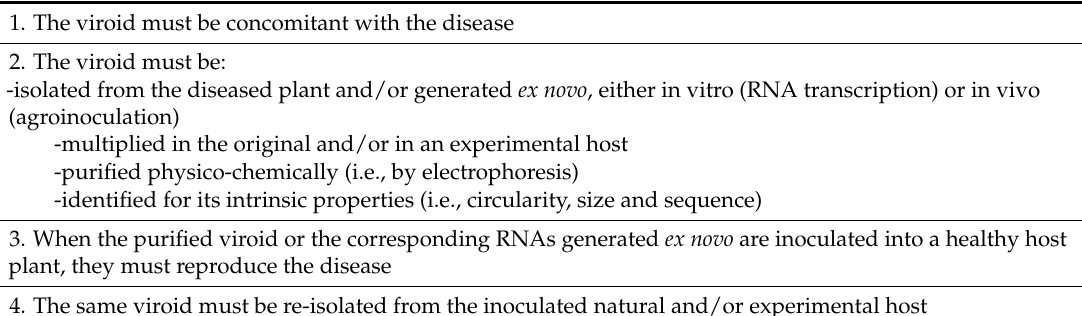
Table 1. Koch’ postulates for providing evidence of the involvement of a viroid in a plant disease